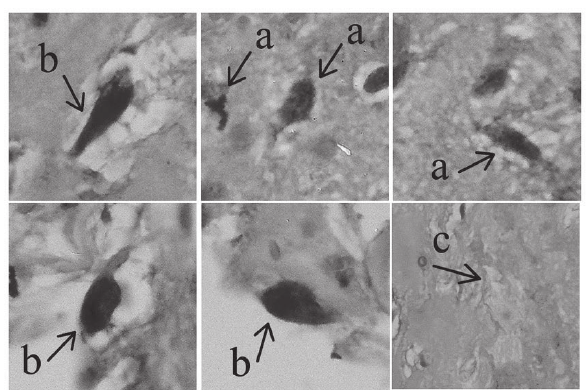
Fig. 2 - Fotomicrografia em 400x mostrando em detalhe mitoses atípicas (a), células bizarras (b) e área de necrose